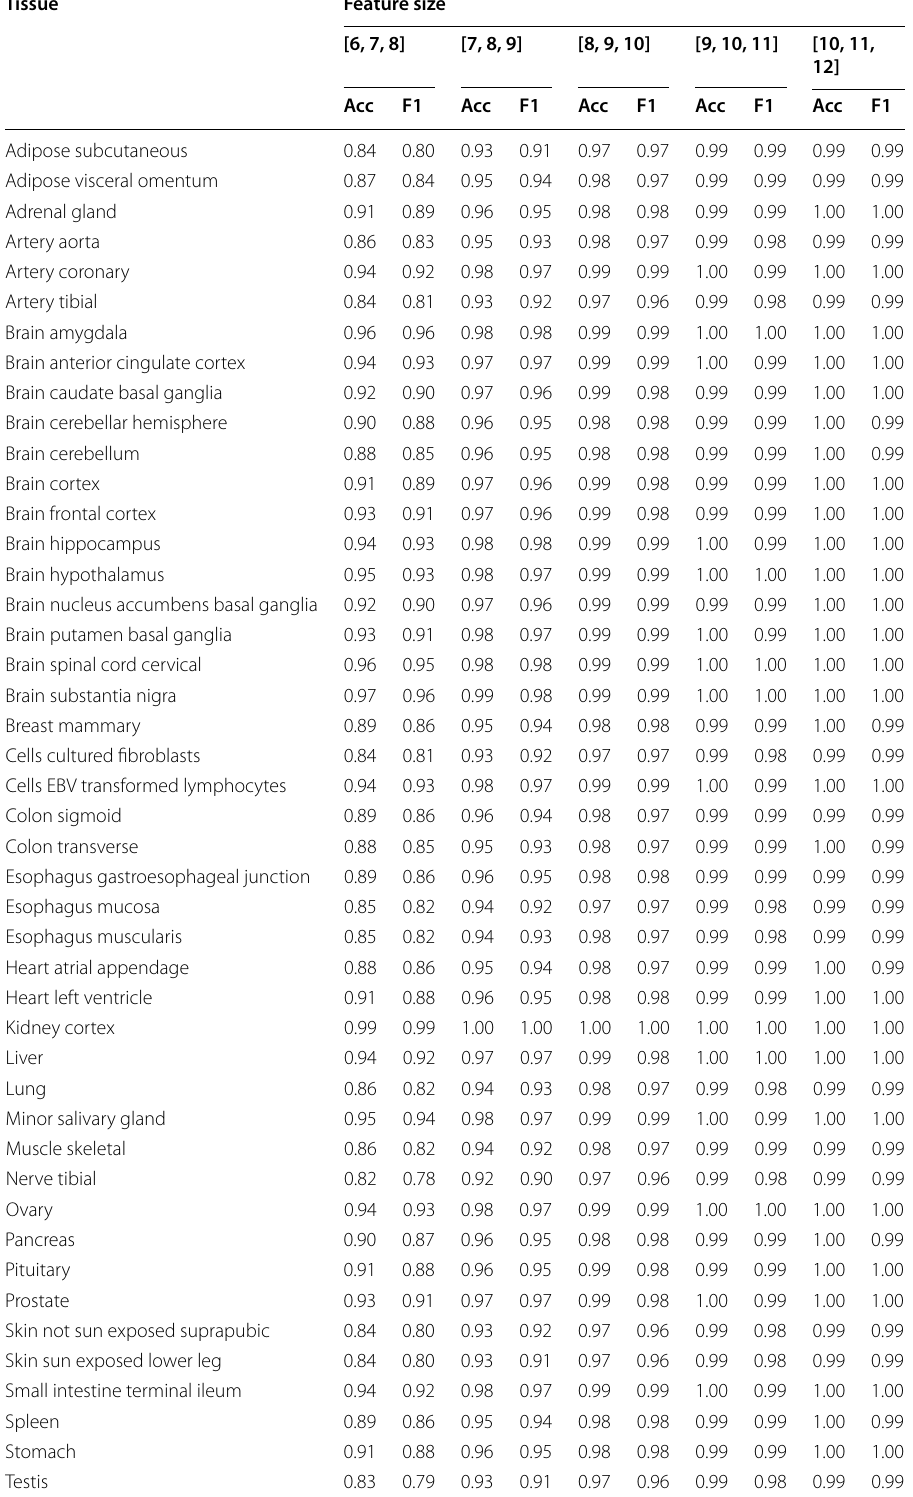
Table 3 Effects of varying feature sizes on all the Test-3 dataset when k-mer size is 3 for the forward feature set